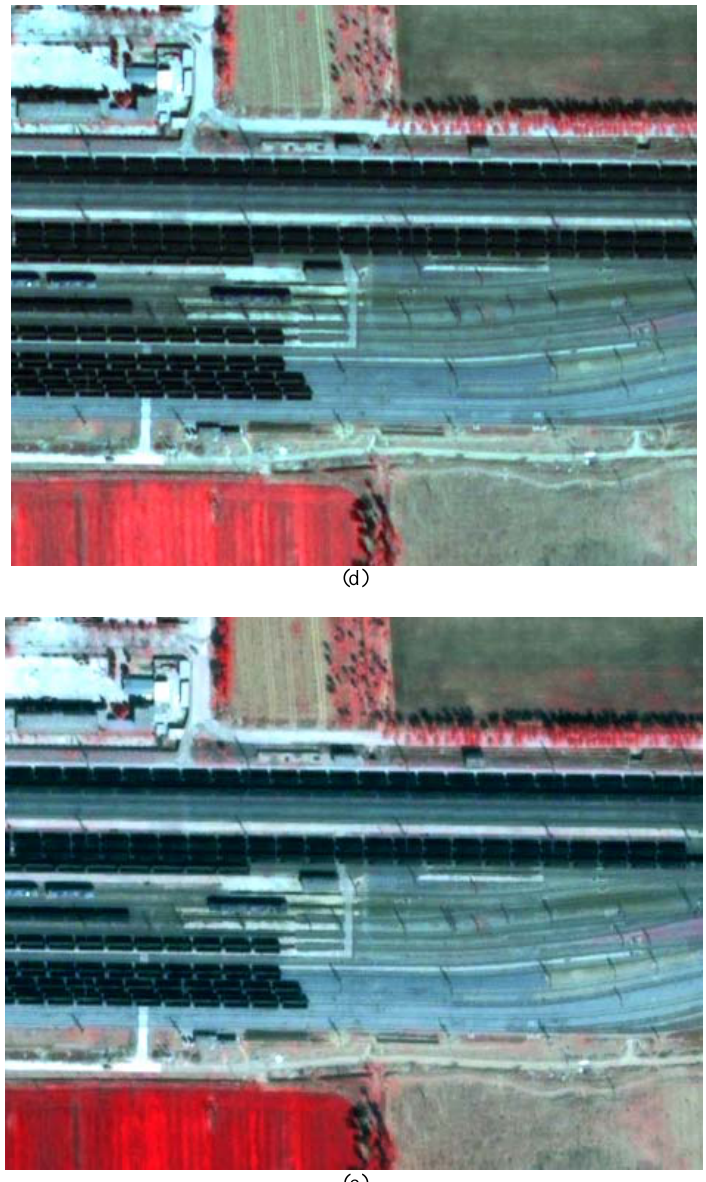
Fig. 4 Visual Comparison of Different Algorithms. (a) QuickBird panchromatic image; (b) QuickBird multispectral image; (c) Fusion result of BR algorithm in the framework, color composite of 4, 3, 2 bands; (d) Fusion result of IHS fusion algorithm in the framework, color composite of 4, 3, 2 bands; (e) Fusion result of MOD. IHS Resolution Merge algorithm in ERDAS, color composite of 4, 3, 2 bands.